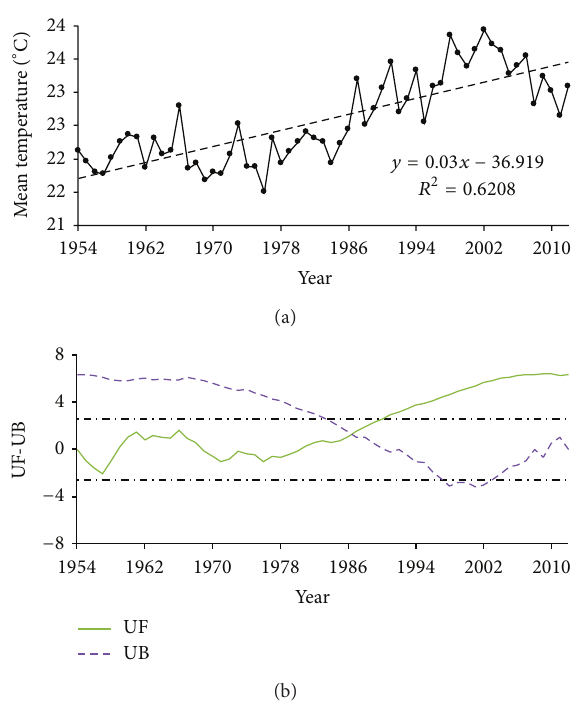
Figure 6: Temporal trend of themean temperature (a) and the trend results from the Mann-Kendall method (b).